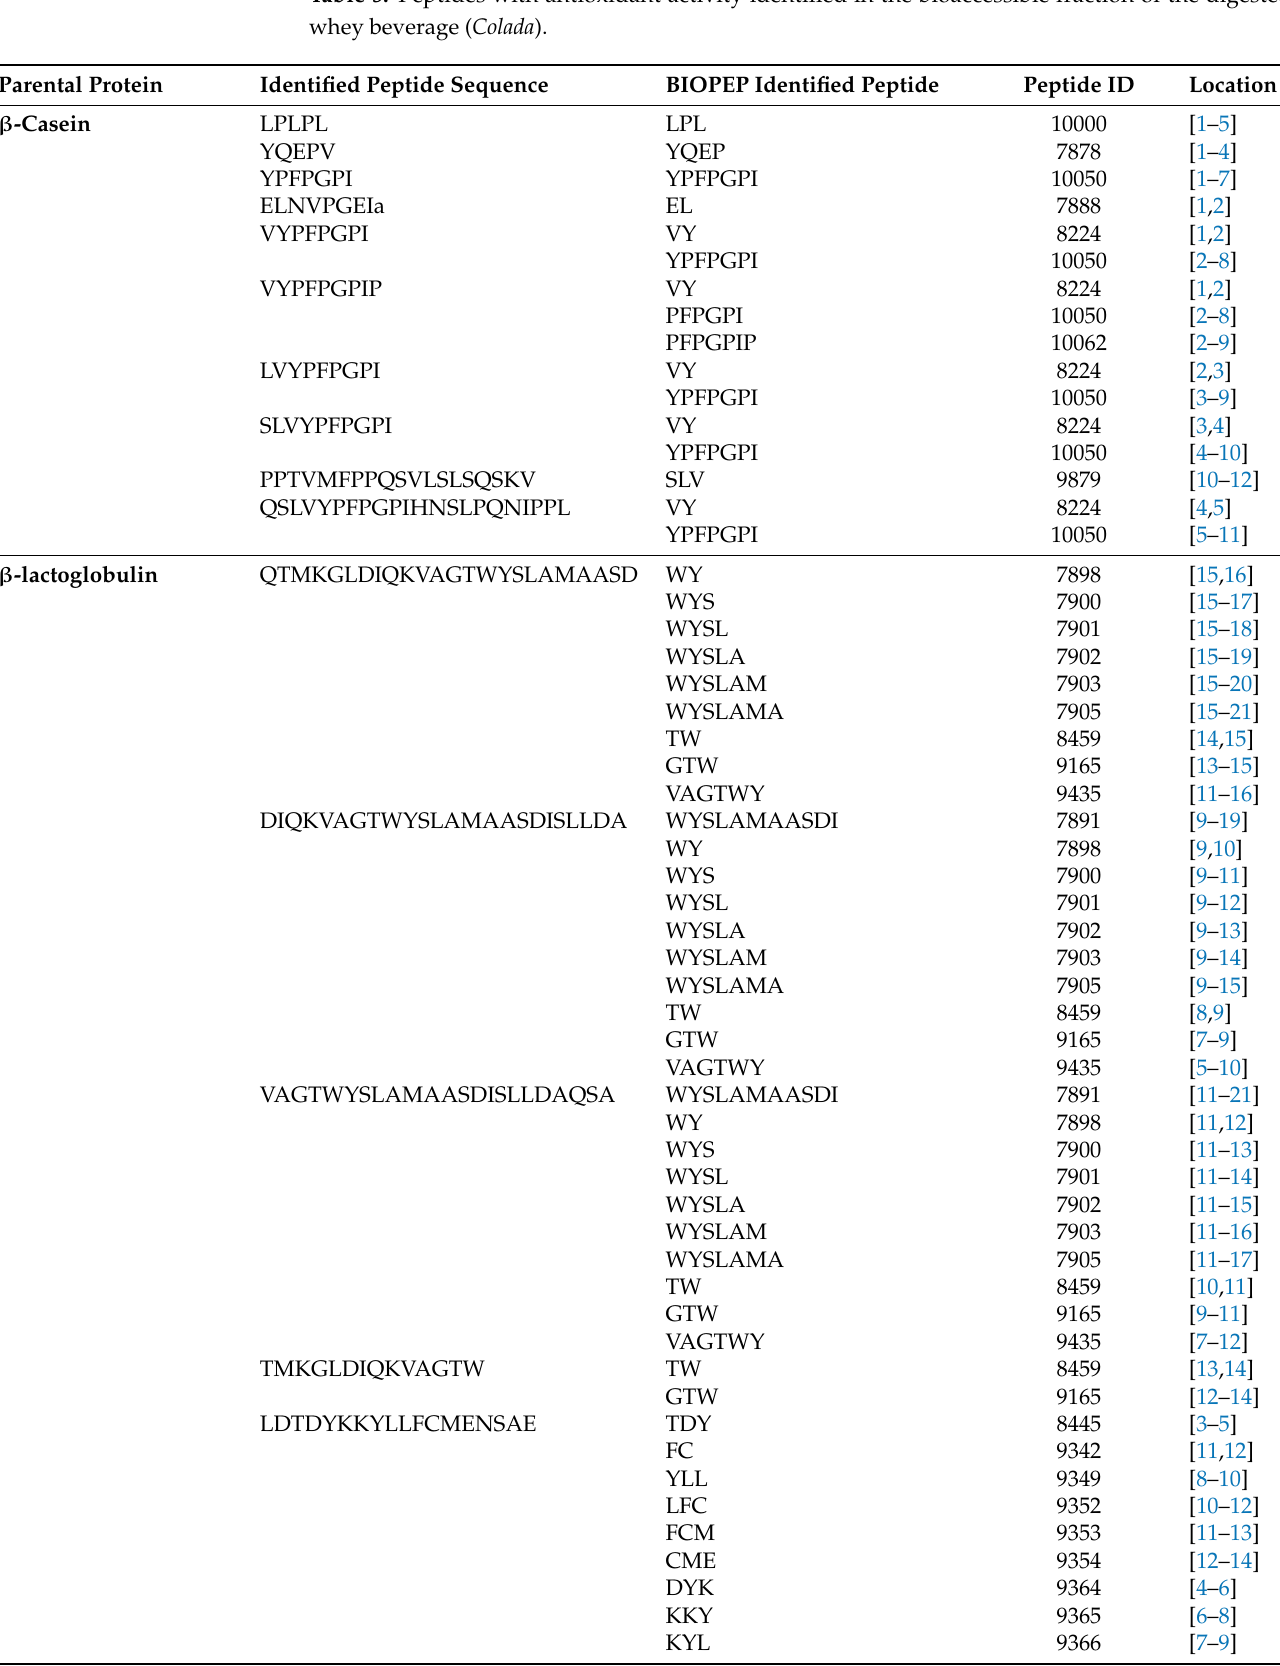
Table 5. Peptides with antioxidant activity identified in the bioaccessible fraction of the digested whey beverage ( Colada